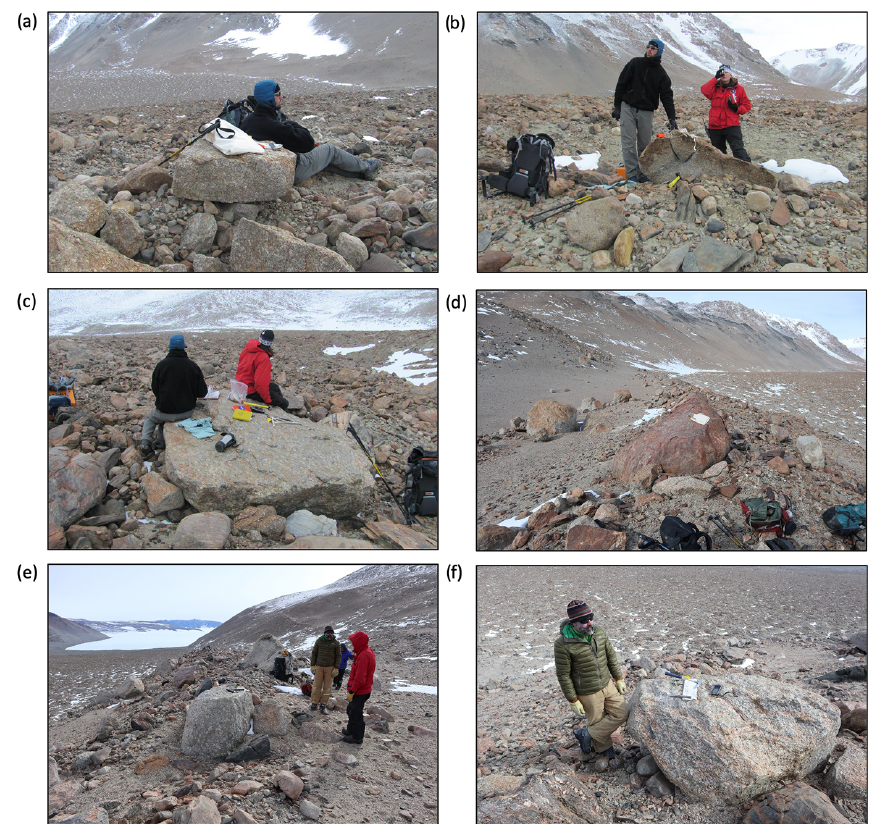
Figure 4. Photographs of surface boulders sampled from (a–c) the Middle drift surface and (d–f) the east lateral moraine; (a) 11-OV-ER-117, (b) 11-OV-ER-118, (c) 11-OV-ER-119, (d) 17-OV-ERR-213, (e) 17-OV-ERR-217, and (f)